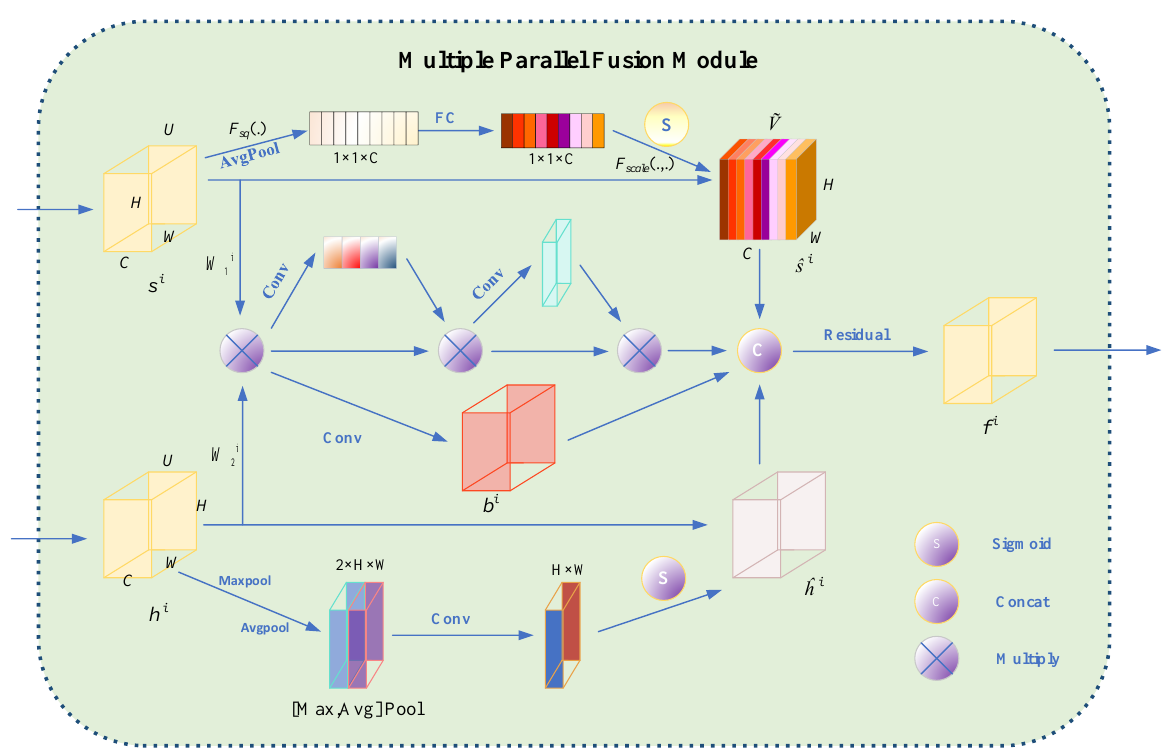
Figure 14. Multiple Parallel Fusion Model for the Protein Subcellular Localization from Label-free live cell imaging.